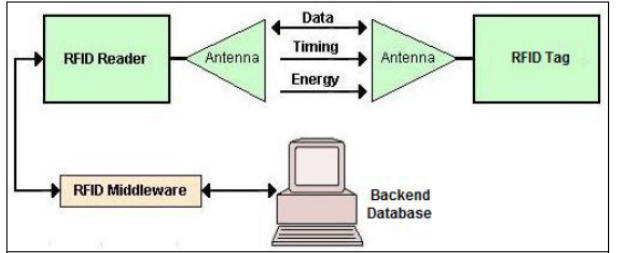
Fig. 1.0 Components of RFID System